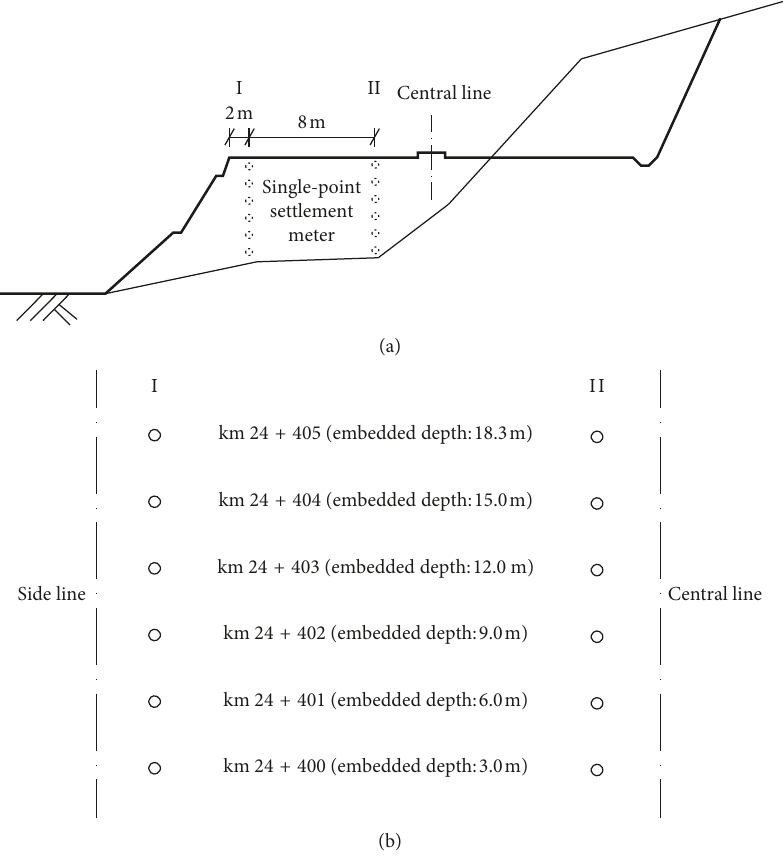
was filled with gravel. The physical and mechanical prop- erties of the subsoils are shown in Table 1.